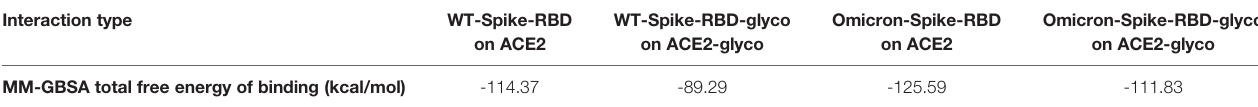
TABLE 2 | Free energy of binding (expressed in kcal/mol) obtained with the MM-GBSA calculations executed on the different complexes considered in this study (WT- Spike-RBD/ACE2, WT-Spike-RBD-glyco/ACE2-glyco, Omicron-Spike-RBD/ACE2, and Omicron-Spike-RBD-glyco/ACE2-glyco). Interaction type